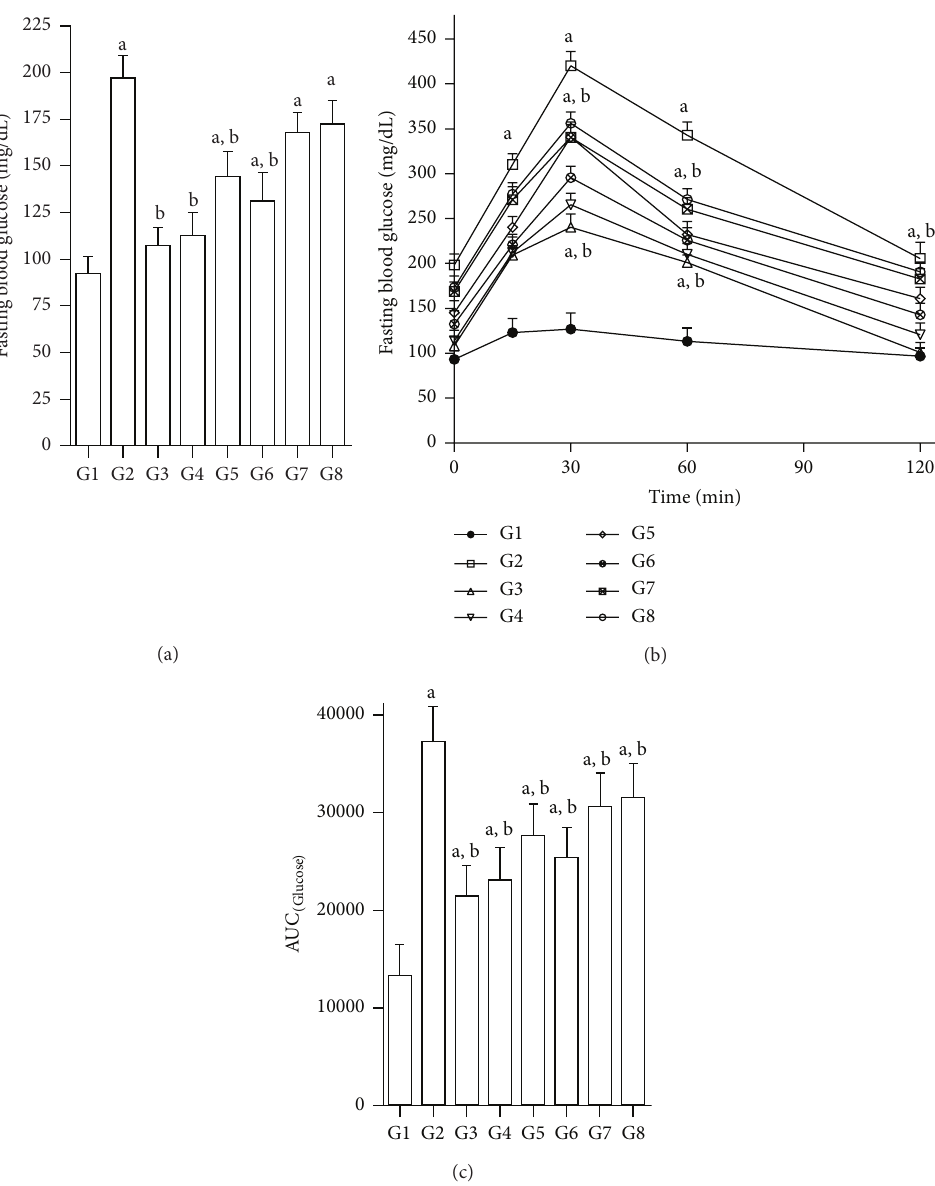
Figure 2: Effect of test compounds on FBG and OGTT in nicotinamide-STZ diabetic rats; (a) fasting blood glucose (FBG) (mg/dL); (b) OGTT; and (c) area under the curve [AUC]; G1: normal control; G2: diabetic control (nicotinamide + STZ); G3: diabetic + glibenclamide (2.5 mg/kg); G4: diabetic + quercetin (10mg/kg); G5: diabetic + JY-1; G6: diabetic + JY-2; G7: diabetic + JY-3; G8: diabetic + JY-4; (test compounds at optimised dose of 80 mg/kg); a 𝑃 < 0.05 compared to normal rats (G1); b 𝑃 < 0.05 compared to diabetic rats (G2) (one-way ANOVA followed by Tukey’s post-hoc